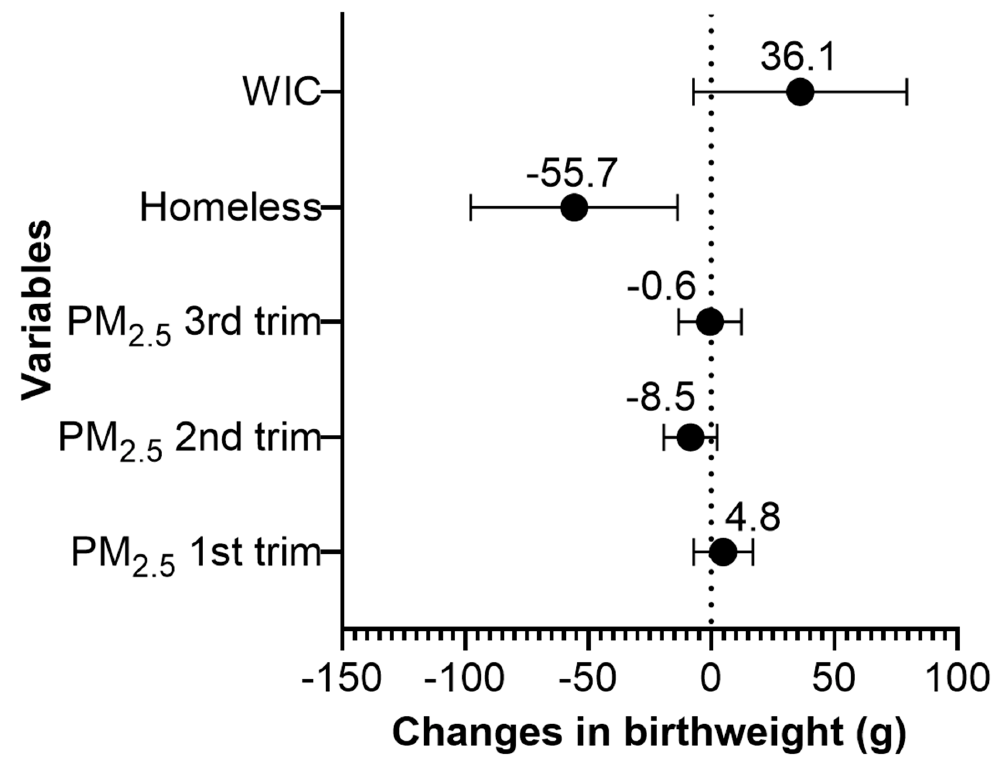
Figure 2. Change in birthweight (g) for a 1 µg/m 3 increase in the average PM 2.5 during the 1st, 2nd, and